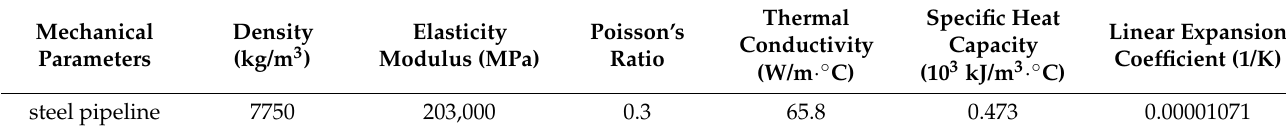
Table 2. Mechanical parameters of the steel pipeline.